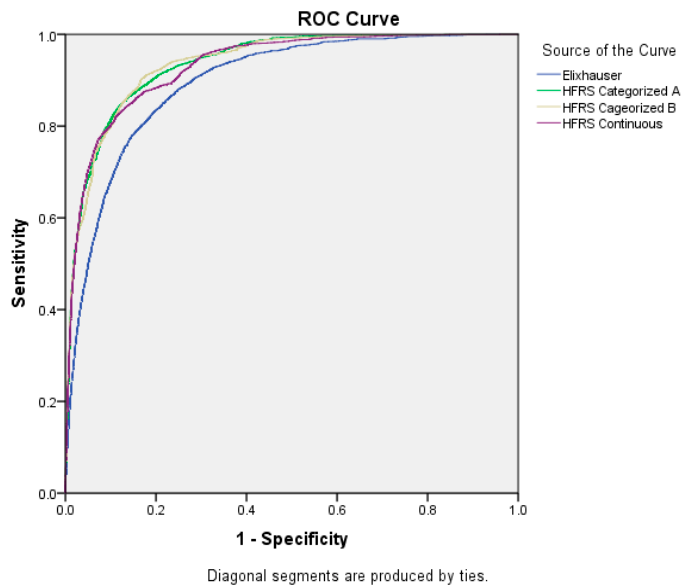
Figure 1. Area Under the Curve for the different parameters considered: separate multivariable models for Elixhauser Comorbidity Index and HFRS.